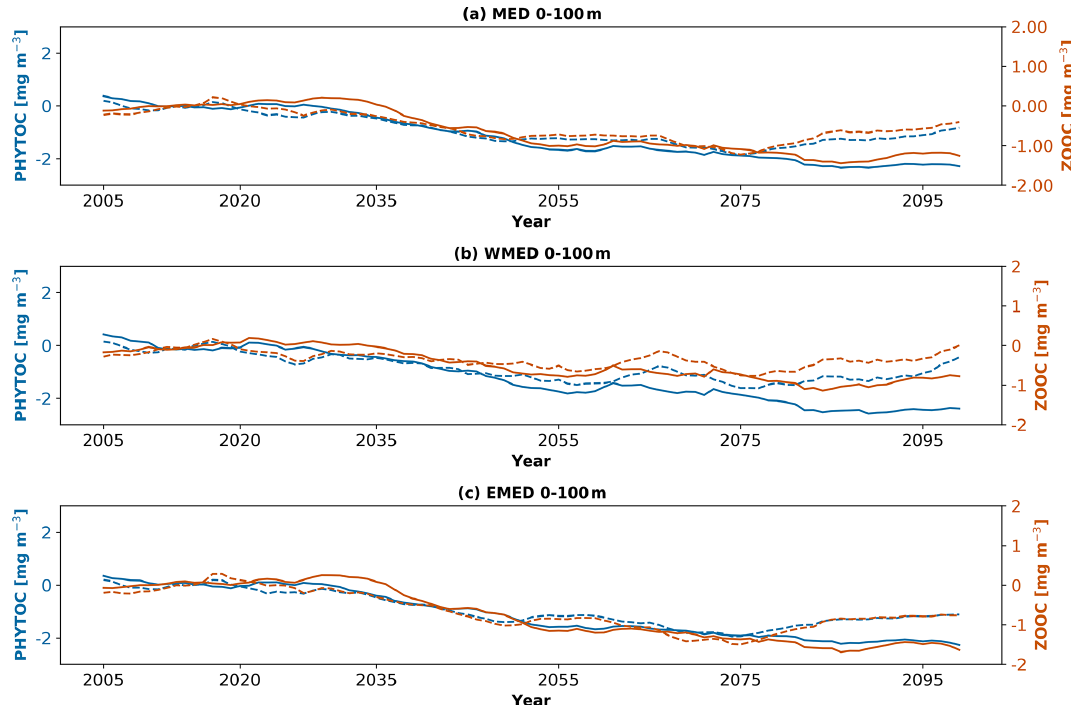
Figure 13. Yearly time series of phytoplankton carbon biomass (blue, in mgm − 3 ) and zooplankton carbon biomass (dark orange, in mgm − 3 ) anomalies for the emission scenarios RCP8.5 (solid lines) and RCP4.5 (dashed lines) in the Mediterranean Sea (MED, a ), Western Mediter- ranean (WMED, b ) and Eastern Mediterranean (c) for the 0–100m layer and the 2005–2099 period. The yearly time series have been smoothed using the 10-year running